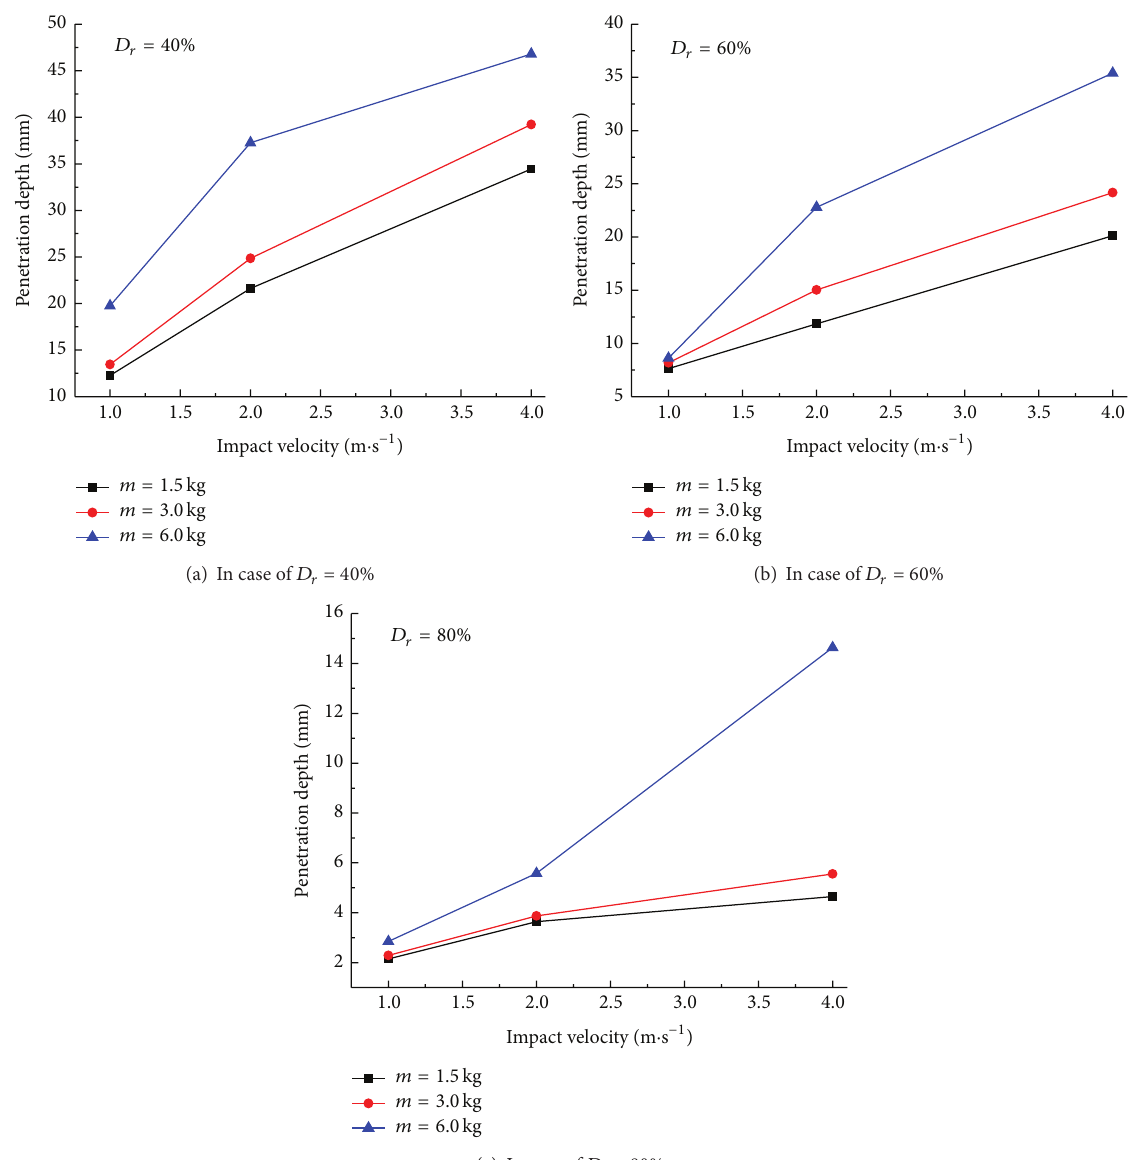
Figure 21: Effect of impact velocity on penetration